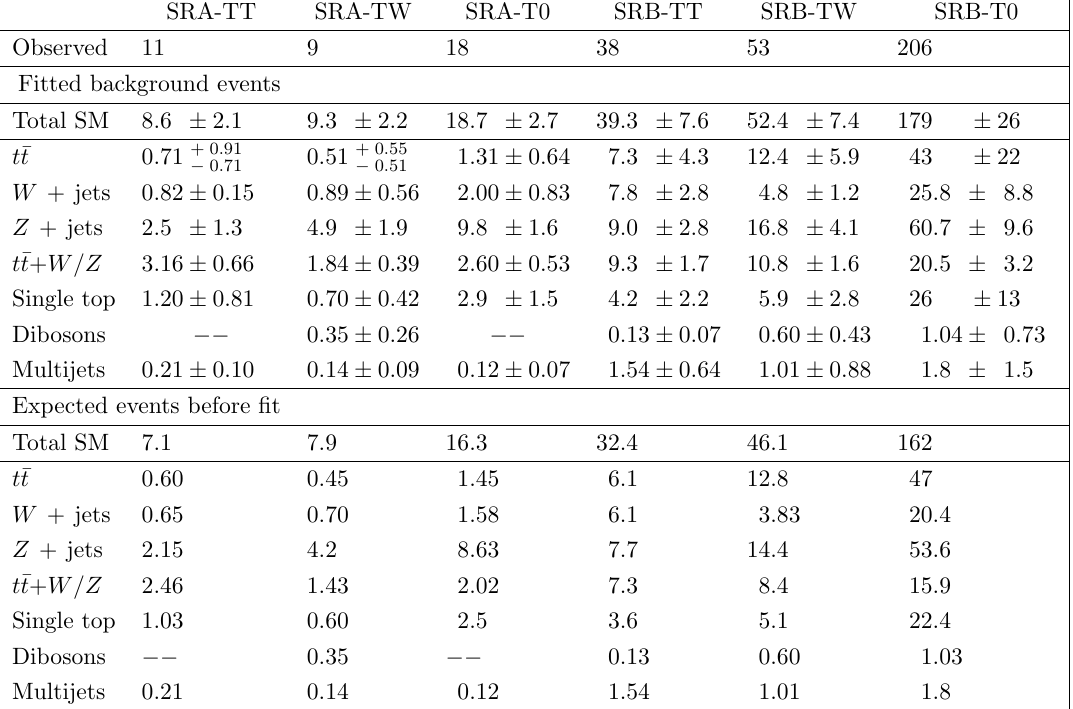
Table 11. Observed and expected yields, before and after the (cid:12)t, for SRA and SRB. The uncertain- ties include MC statistical uncertainties, detector-related systematic uncertainties, and theoretical uncertainties in the extrapolation from CR to